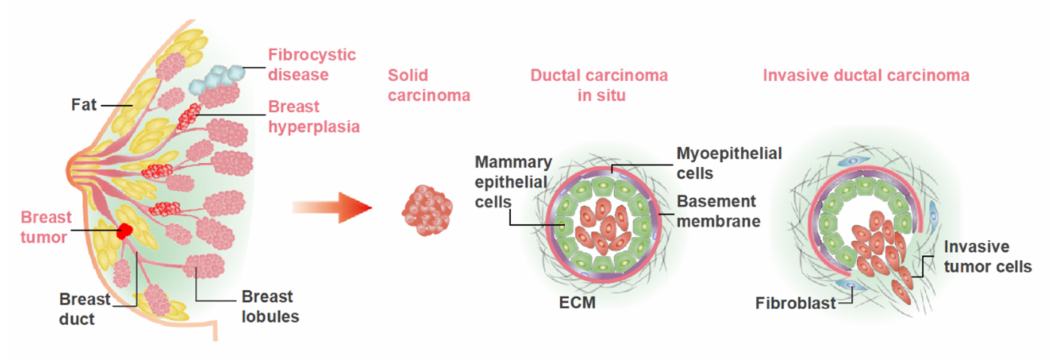
Figure 1. The physiological structure of mammary gland and the common breast diseases. The benign diseases mainly include breast hyperplasia, fibrocystic disease, benign tumor, etc. The malignant tumors mainly include solid carcinoma and ductal